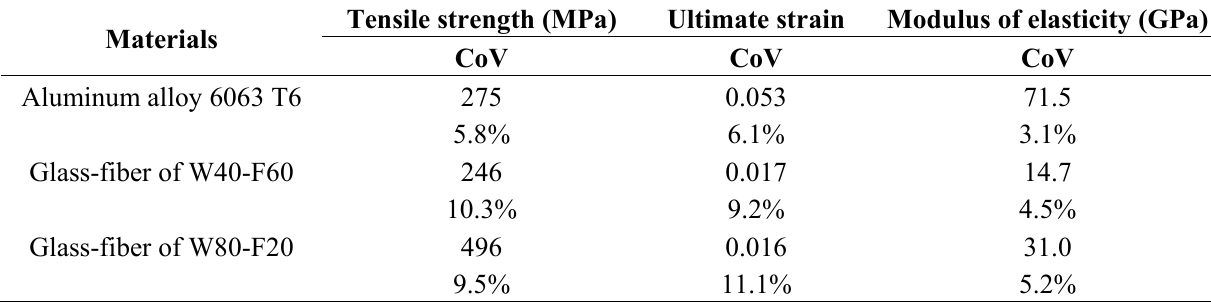
Table 1. Physical properties of materials comprising aluminum-glass fiber composite (AGC)